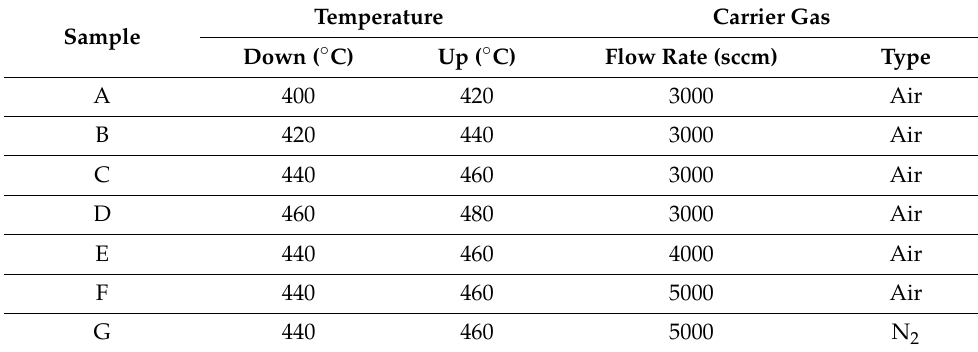
Table I. Film growth conditions.